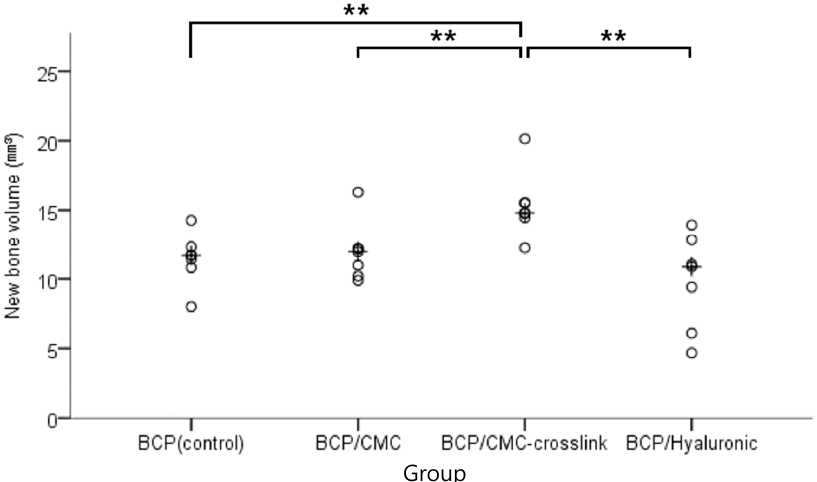
Figure 8. Micro-CT analysis results: scatter plot and median (indicated the cross) representing new bone volumes (mm 3 ). The BCP/c-CMC group shows the highest level of new bone production. The symbol “**” indicates statistical significance ( p < 0.05).